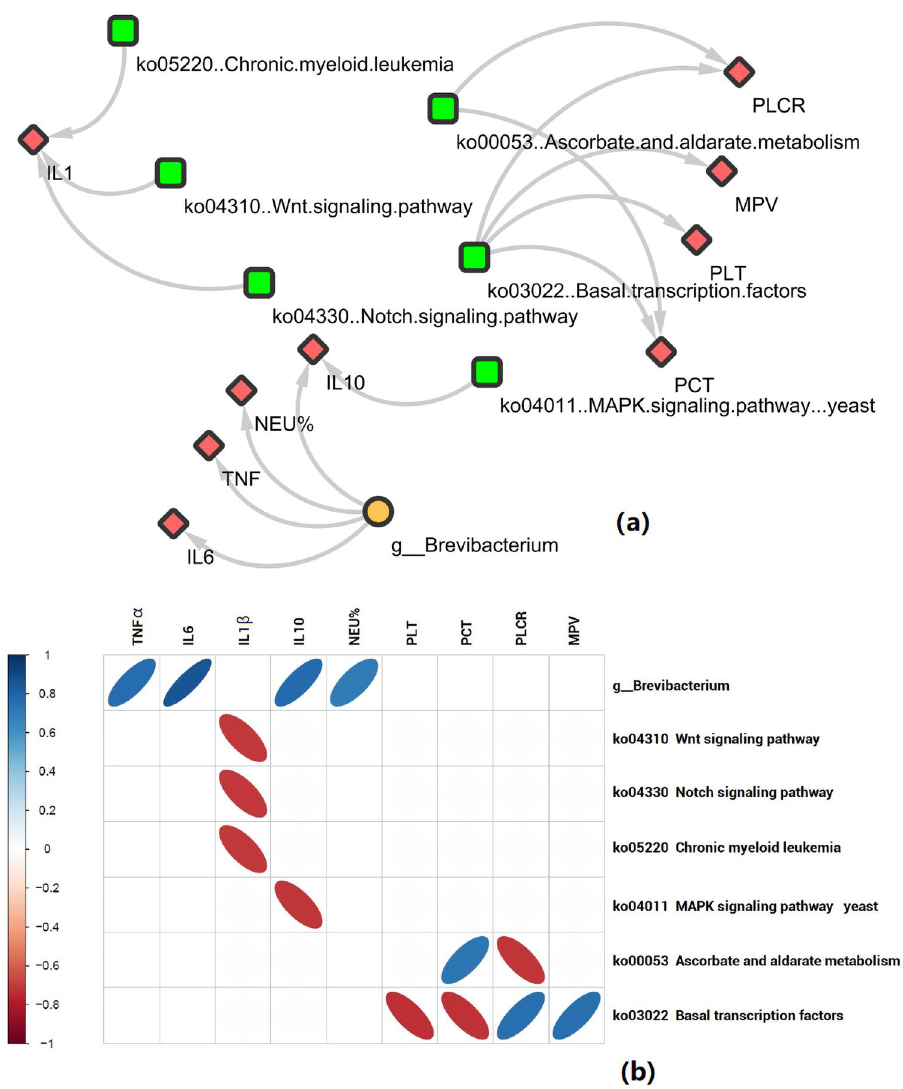
Figure 6. Correlations between host and microbiota parameters. ( a ) Host–microbiota interaction network. Network shows correlations between genus-level components and functionality pathways in lung microbiota and LPS-induced host ALI/ARDS symptoms from all samples. Lines between nodes represent correlations. Lines were drawn only for statistically significant correlations with absolute values of correlation coefficient > 0.70; unconnected nodes were omitted. ( b ) Spearman’s pairwise correlation. Blue = positive correlation; red = negative correlation. NEU% percentage of neutrophils, MPV mean platelet volume, PLCR platelet/large-cell ratio, PLT platelet count, PCT platelet packed